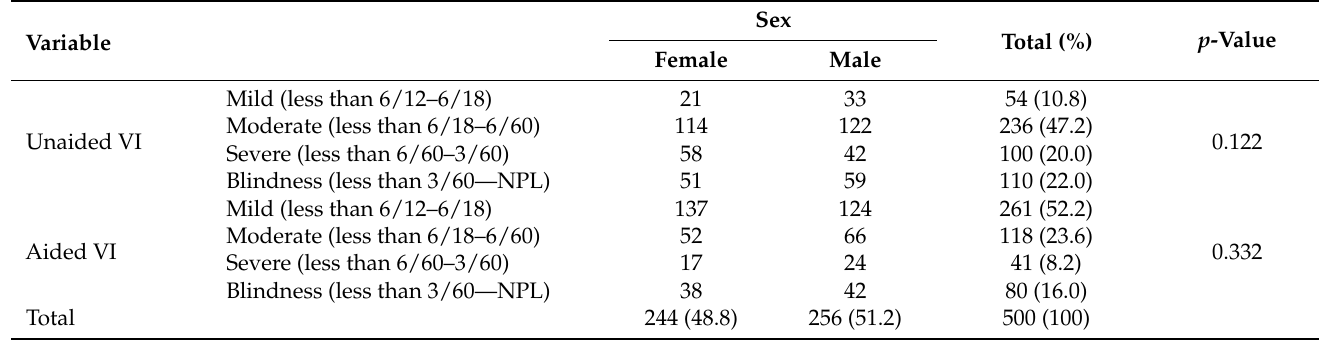
Table 2. Distribution of unaided and aided visual impairment according to sex.